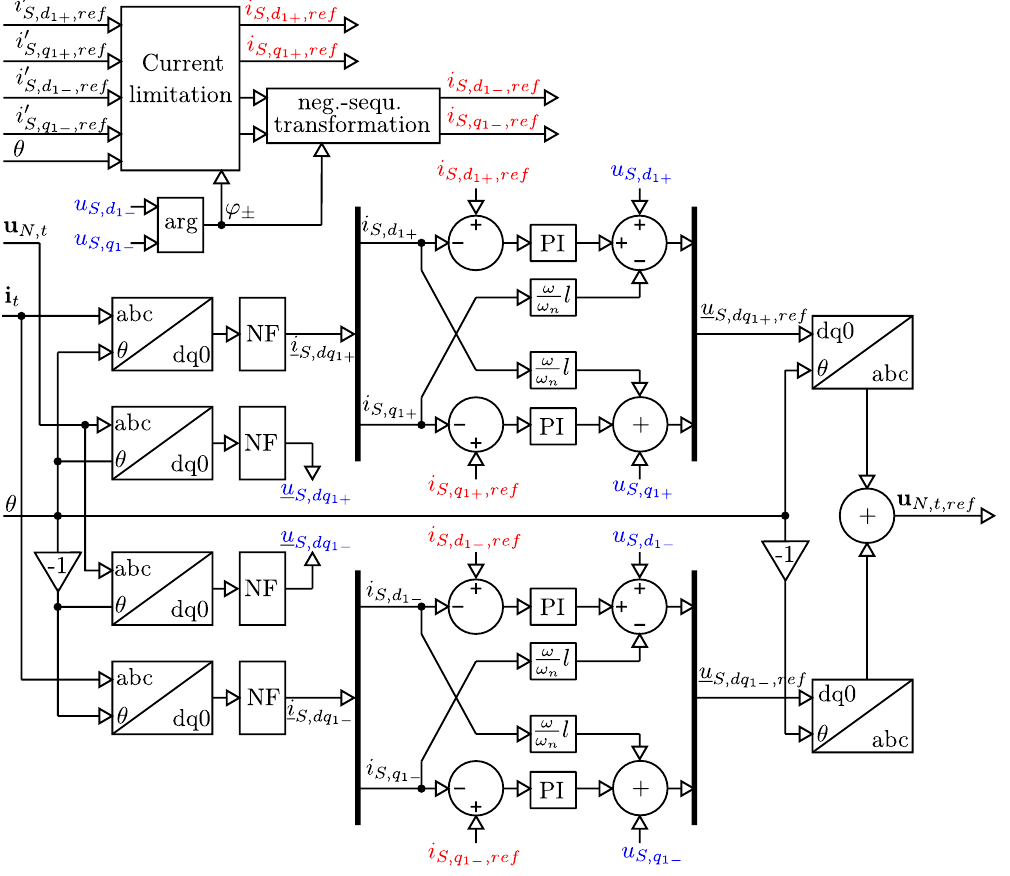
Figure 4. “Inverter current control”-block of Figure 3, using a double synchronous reference frame (DSRF) with notch filters (NF) based on [8]. The current limitation implements the explanations in Section 1.2 (R of Equation (25) is